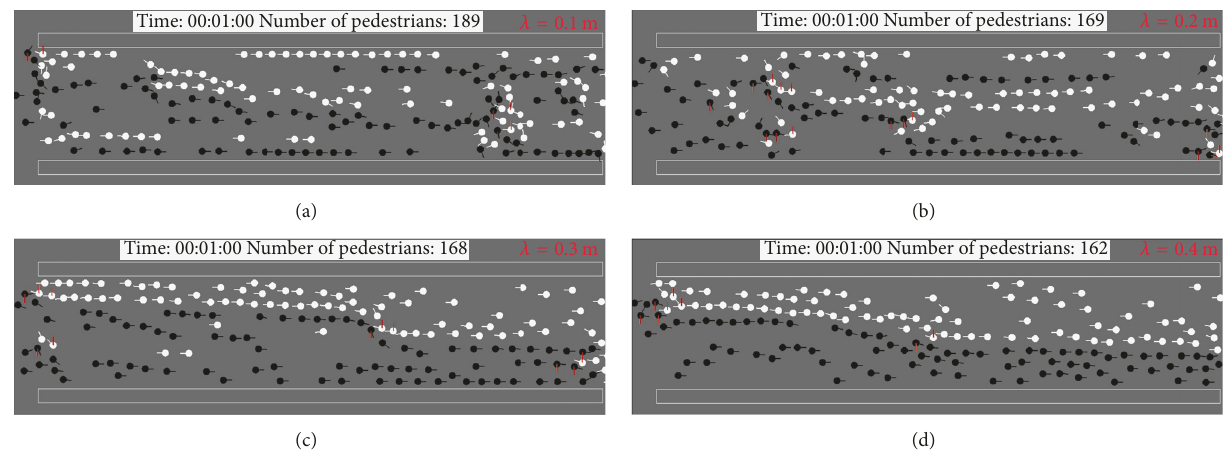
Figure 13: The simulation snapshots of lane formation for different 𝜆 . In the simulation, the length of passage 𝐿 = 40 m and the width of passage 𝑊 = 8 m. We use the black and white circles to represent the pedestrian access from both sides of the passage, and we use the black and white lines in front of the circles to represent the current movement direction of pedestrians. The red lines represent the direction of f 𝑟𝑝 . When simulation time 𝑡 = 60 s, we take snapshots for comparison. In (a) 𝜆 = 0.1 m; in (b) 𝜆 = 0.2 m; in (c) 𝜆 = 0.3 m; and in (d) 𝜆 = 0.4 m.